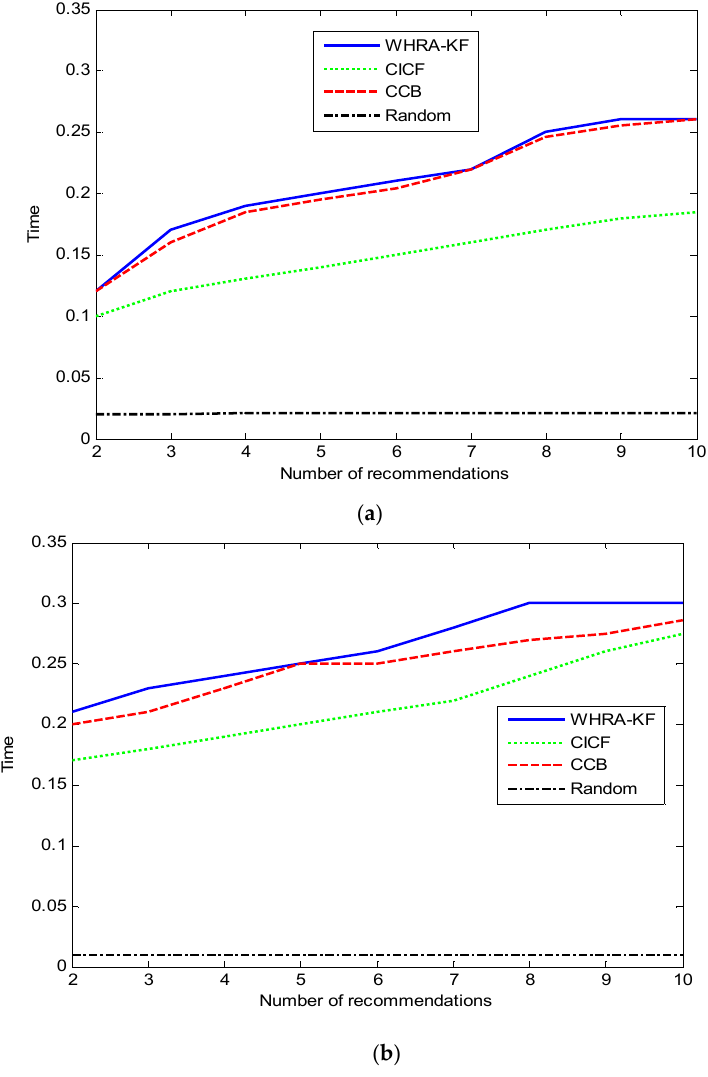
Figure 12. Time VS number of recommendation for smart home, ( a ) Standard smart home ( 50 n ); ( b ) Deluxe smart home ( 100 n ).